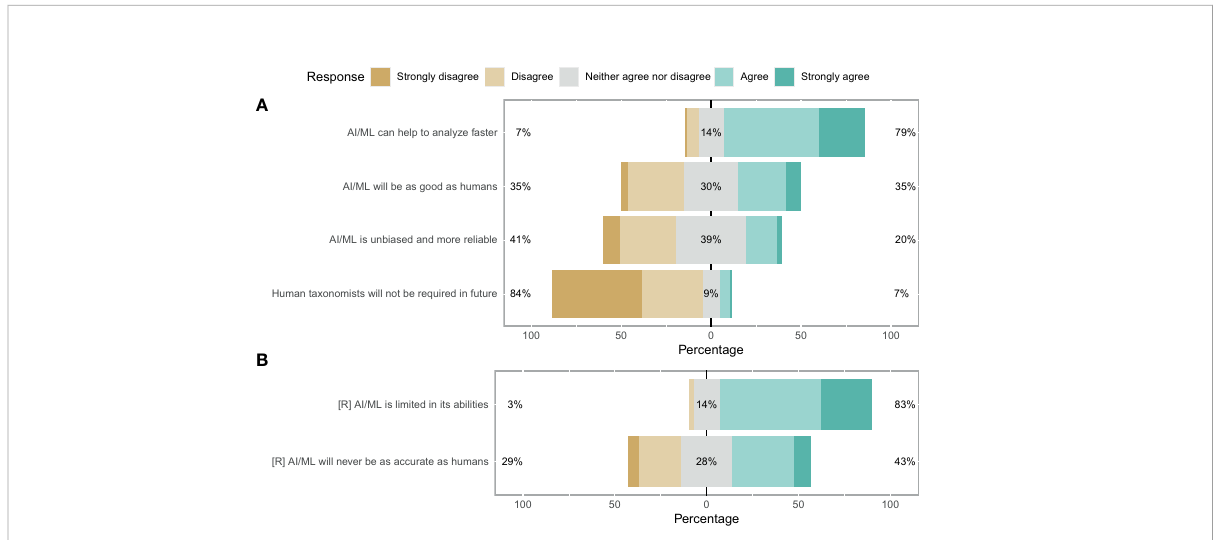
FIGURE 5 Likert plot for taxonomy suf fi ciency. (A) More green means consensus favours the replacement of human taxonomists with AI. More brown means a preference for keeping the system as it is. An equal spread likely indicates no clear consensus. (B) Reverse as for